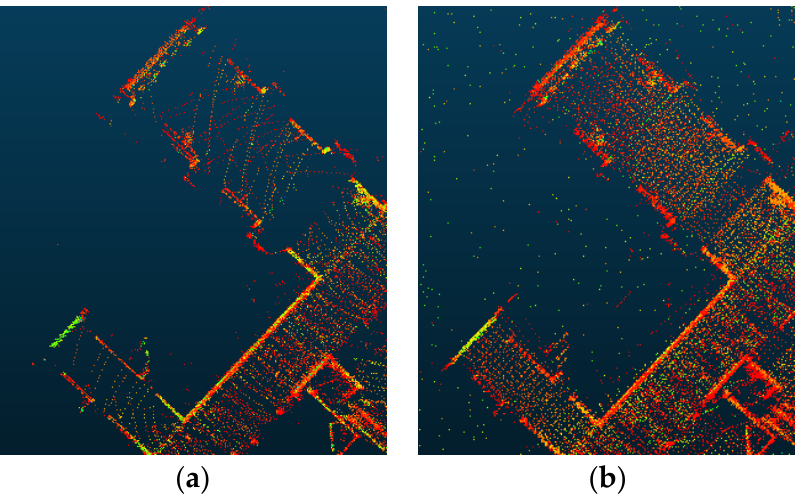
Figure 9. Comparison of mapping details at the top of the corridor, where ( a ) the mapping of LIO-SAM lacks top information and ( b ) the mapping of HSDLIO shows finer structural details of the environment .